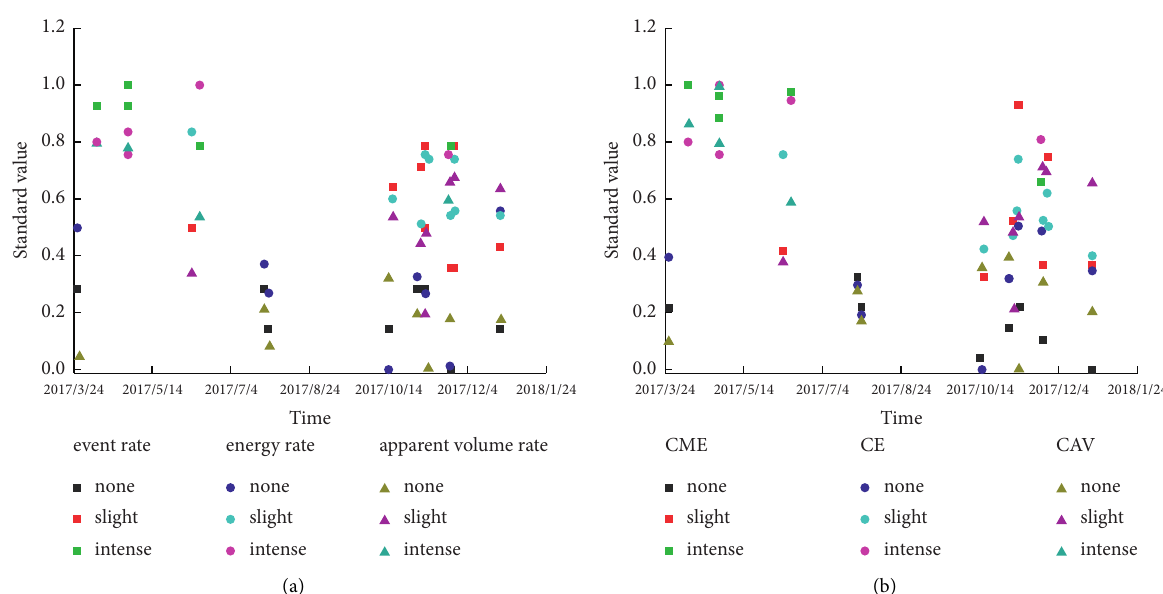
Figure 6: The whole processed time series of the six indicators. (a) Event rate, energy rate, and apparent volume rate. (b) Cumulative number of event (CME), energy (CE), and apparent volume